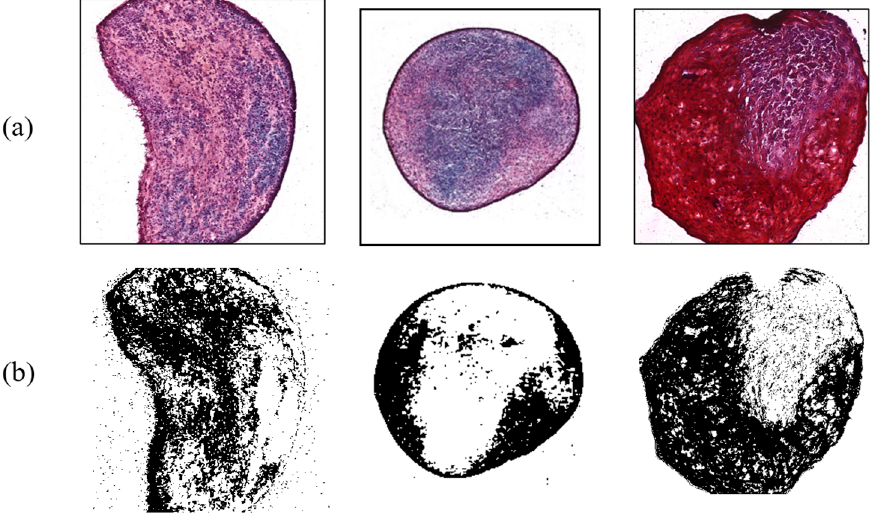
Figure 8. Chondrogenesis with shear force. ( a ) Safranin-O-stained MSCs; ( b ) ImageJ results.